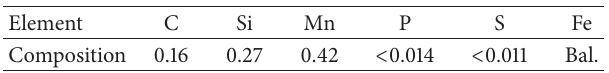
Table 1: Chemical composition of experimental carbon steel (in